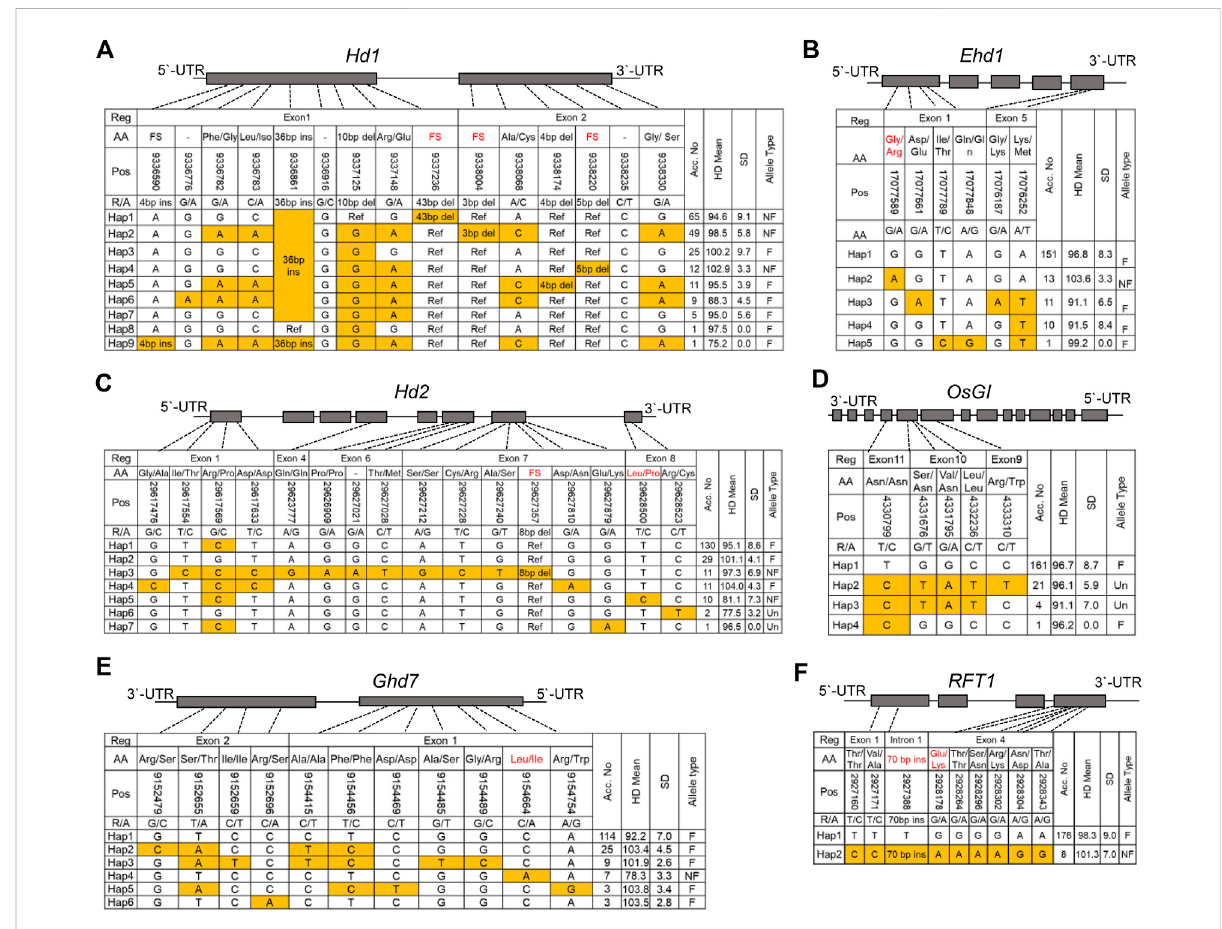
FIGURE 6 Haplotype analyses of the major Hd genes ( Hd1 (A) , Ehd1 (B) , Hd2 (C) , OsGI (D) , Ghd7 (E) and RFT1 (F) ) with allelic variance (SNPs and InDels) in the CDS regions. The allelic frequencies in each rice type are presented in the columns towards the rights of the tables. Reference, Nipponbare